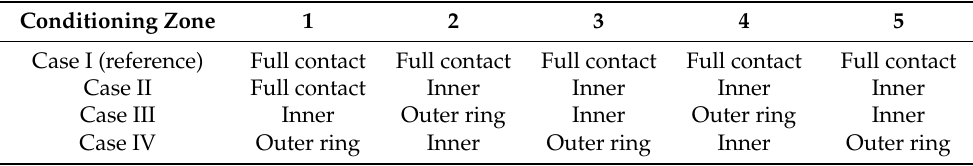
Table 3. Conditioning cases considered in this study.